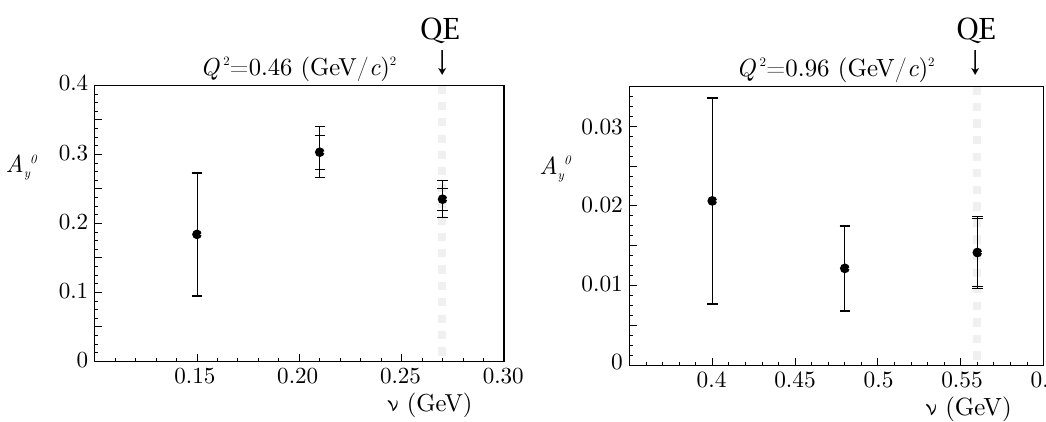
Figure 4: Current A 0 y measurements, along with the NIKHEF [10] Figure 6: The target-normal single-spin asymmetry in the 3 He ↑ ( e,e (cid:48) n ) process as Figure 3: Current measurements of A 0 y at 0 . 46 and 0 . 96 (GeV/ c ) 2 and MAMI [11] data, plotted as a function of Q 2 alongside the values plotted as a function of the energy transfer, ν . The dotted lines functions of energy transfer, for two values of Q 2 . The arrows indicate the location of ε for each data point. Error bars represent the total uncertainties. indicate the center of the quasi-elastic peak. The uncertainties for these data can be found in Table 5. The dot- of the quasi-elastic dashed cross represents the modified PWIA approach used by Laget [9, 10], the dotted and solid crosses represent the non-relativistic Faddeev calculations including FSI and, in the case of the solid cross, MEC [11]. Only the Faddeev calculations, which fully account for FSI, represent the data. The dotted line is an exponential fit of the current world data.